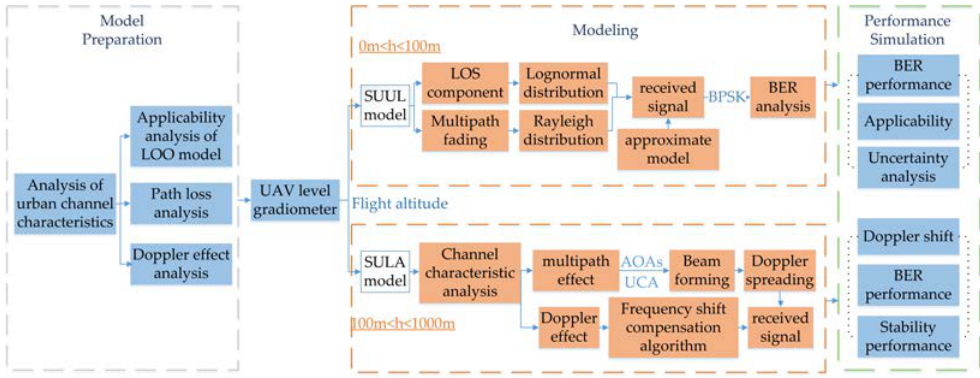
Figure 2. Roadmap of the research.